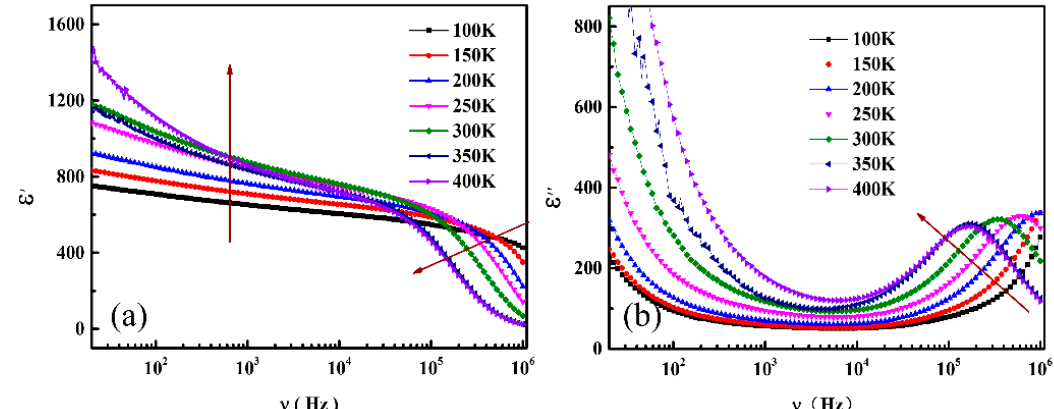
Figure 5. Frequency dependence of ( a ) real and ( b ) imaginary parts of dielectric constant at different temperatures.